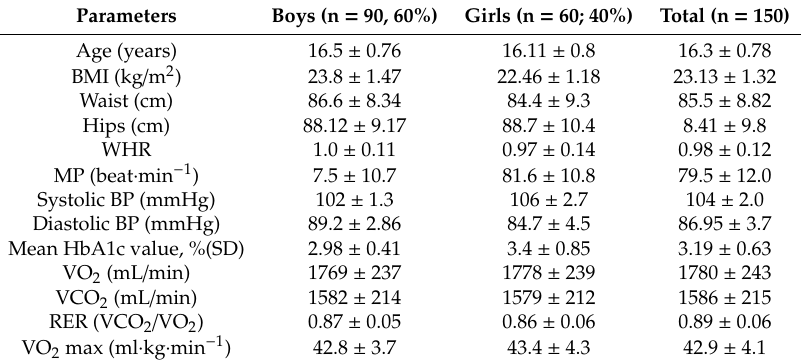
Table 1. General characteristics of participants according to gender (n = 150).